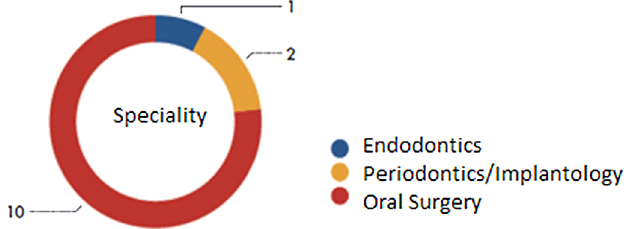
Fig. 2. Practioners with specialized domain.